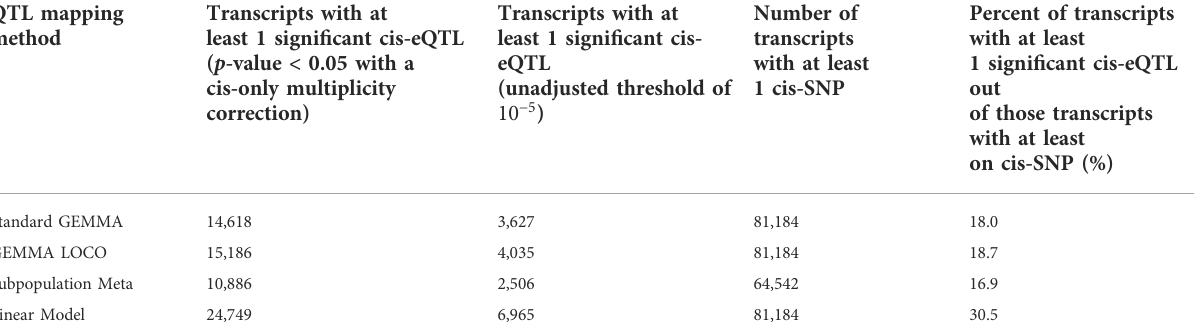
TABLE1Thenumberofgeneswithatleastonesigni fi cantcis-SNPforeachofthefourmethods.Thepercentagesofgeneswithatleast1cis-SNPthat have a signi fi cant cis-eQTL ( p -value < 0.05 with a cis-only multiplicity correction) are displayed in column 5. The number of transcripts with at least one cis-SNP (column 4) varies due to more SNPs failing to pass the minor allele frequency cutoff in the subpopulation meta-analysis approach. QTL mapping